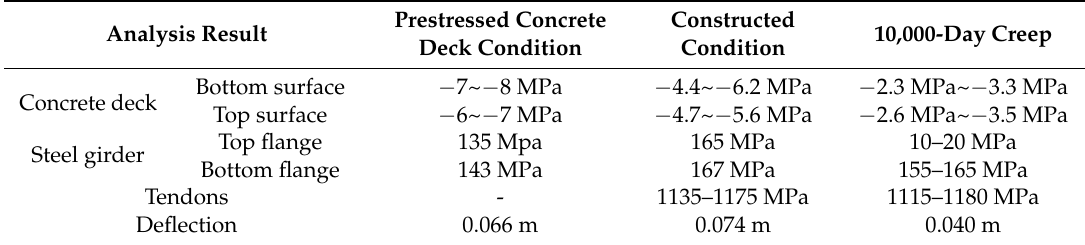
Table 1. Stress and deformation analysis results. Table 1 Stress and deformation analysis results.